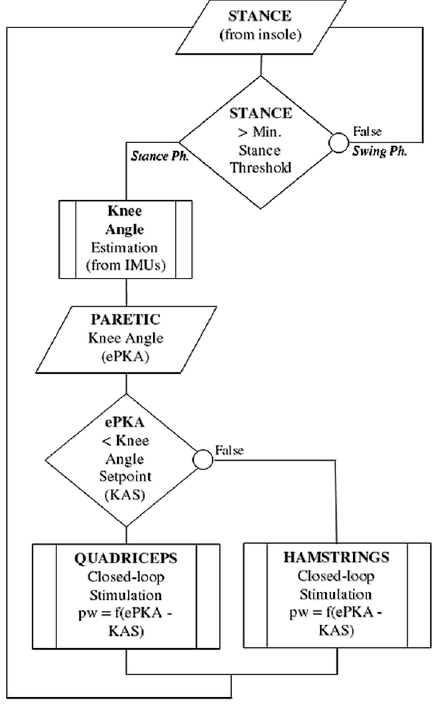
Figure 3. Flowchart of the IF-THEN rules regulating online the stimulation control. The stance phase is detected using a simple threshold on the foot pressure insoles. Stimulation is sent either to quadriceps or hamstrings, depending on the actual paretic knee angle (PKA) compared to the desired KAS (Knee Angle Setpoint) in stance phase. A knee too flexed led to the closed-loop control of the quadriceps, while a knee too extended led to the control of the hamstrings.